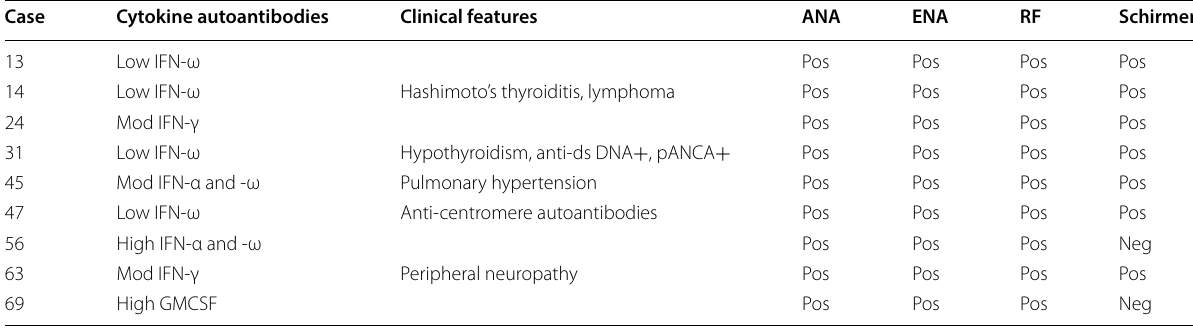
Table 2 Clinical and laboratory features of anticytokine seropositive SS cases Case Cytokine autoantibodies Clinical